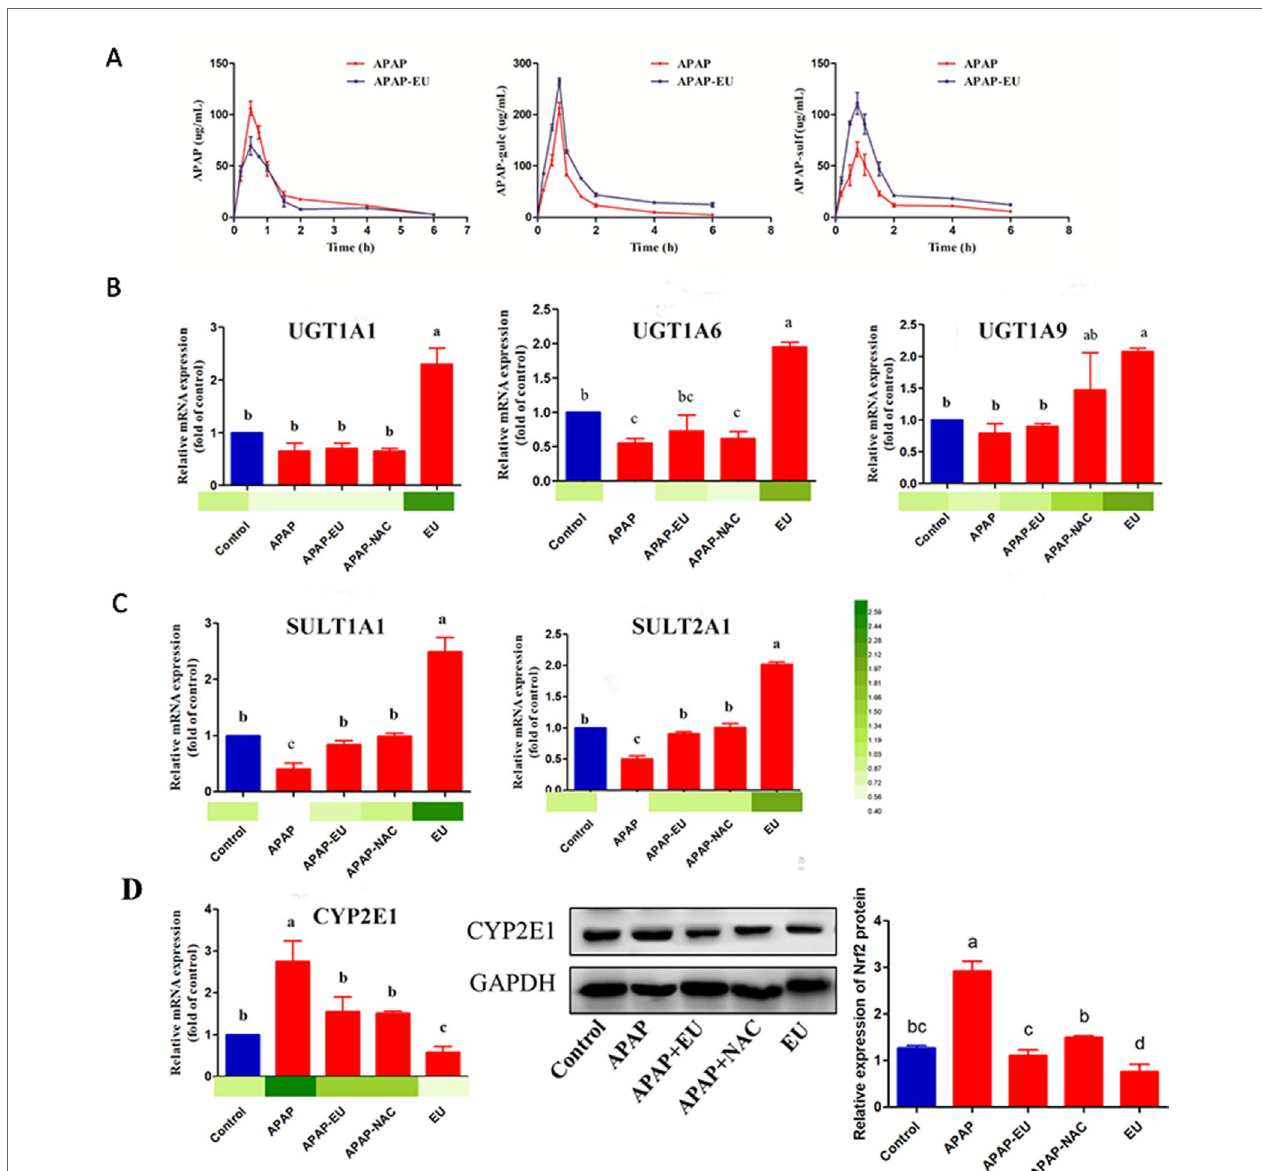
FIGURE 6 | Effects of eucalyptol on the APAP metabolic disposition. APAP: APAP treatment group; APAP+EU: EU was intragastrically administrated after APAP treatment group; APAP+NAC: NAC was oral administration after APAP treatment group. EU: EU was intragastrically administrated. a, b, c different letters indicate statistically different groups ( p <